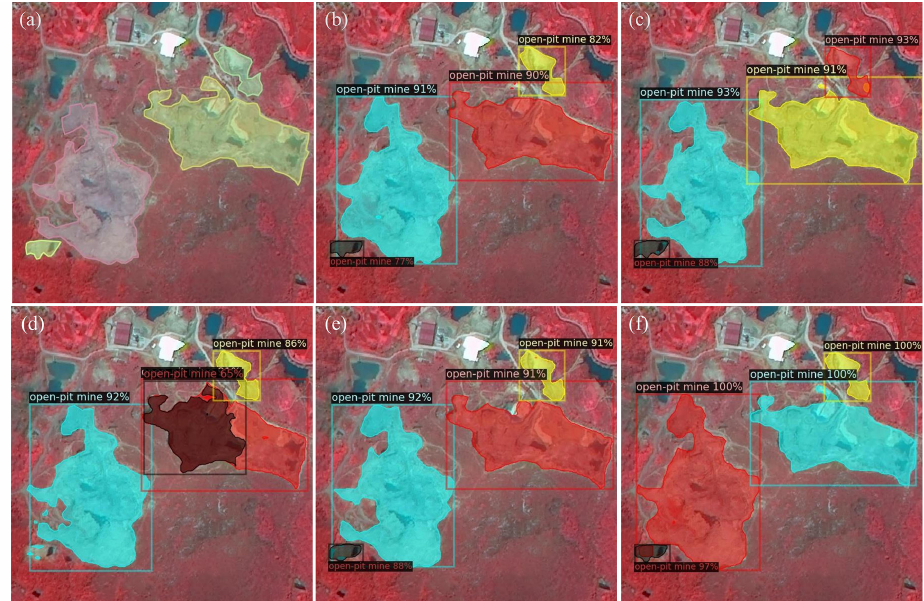
Figure 8. Model inference probabilities and shapes on Gaofen satellite false-color image. ( a ) Ground truth of limestone mines. ( b ) Inference result by BlendMask model; ( c ) inference result by BlendMask- VoV model; ( d ) inference result by CondInst model; ( e ) inference result by CondInst-VoV model; ( f ) inference result by Mask R-CNN model.